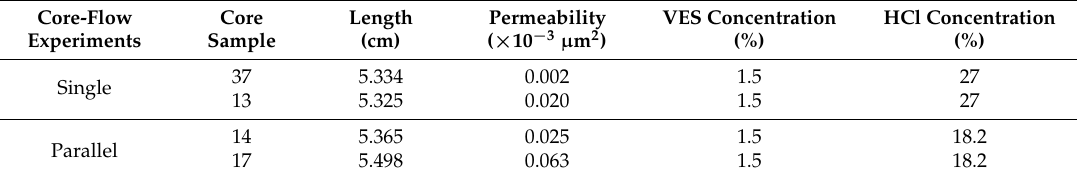
Table 1. Collection of core parameters experimental